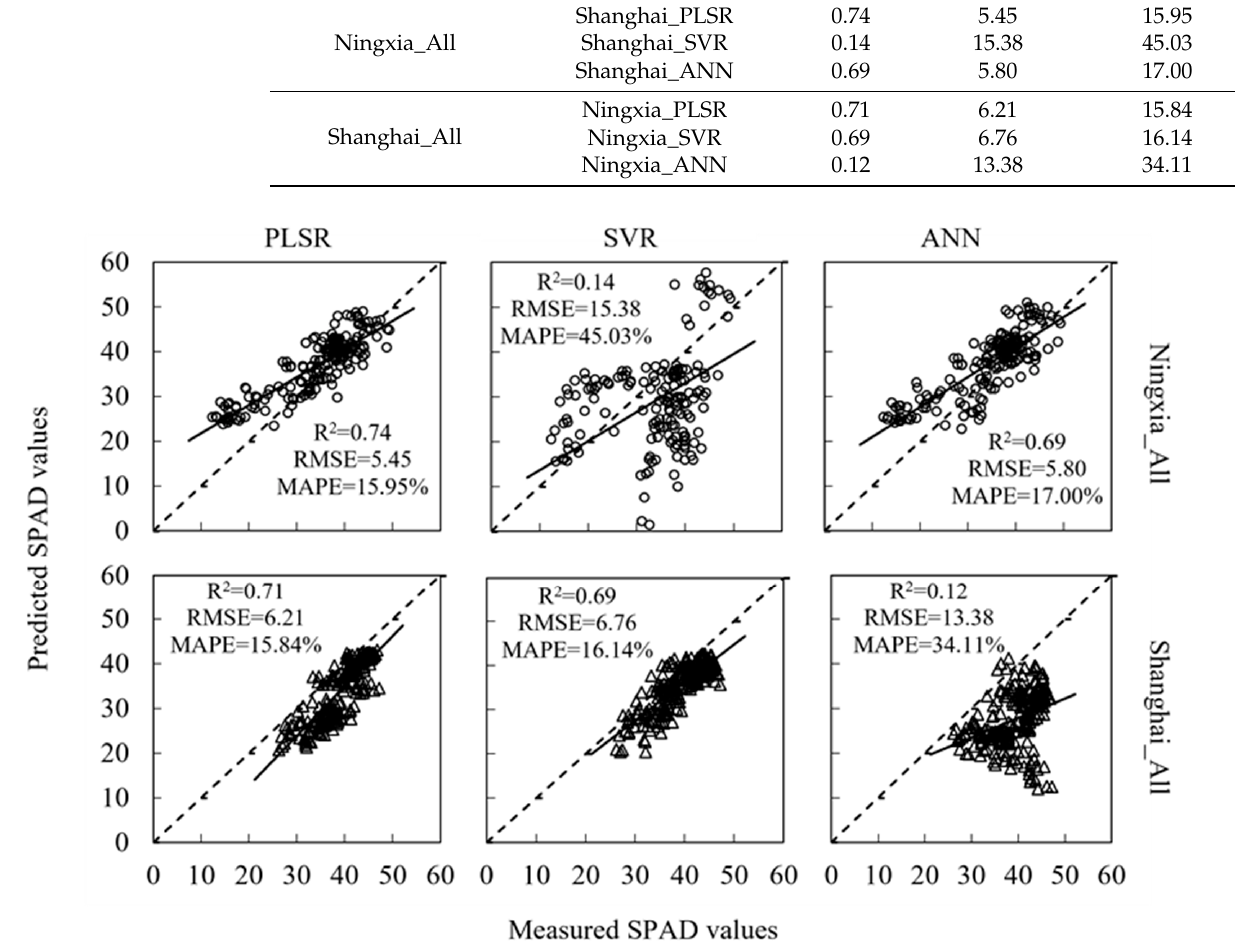
Table 7. Interactive validation of rice LCC estimation models of Ningxia and Shanghai. Validation Dataset